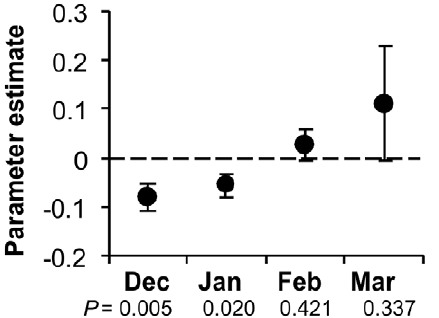
Figure 4. Temporal decay in the efficacy of insecticide treatments against Andean potato weevils ( Premnotrypes spp.), as applied by farmers. The x-axis shows the parameter estimate 6 SEM associated with the effect of a single insecticide application on the proportion of tubers infested with weevils (sqrt- transformed). The y-axis shows the month of the insecticide